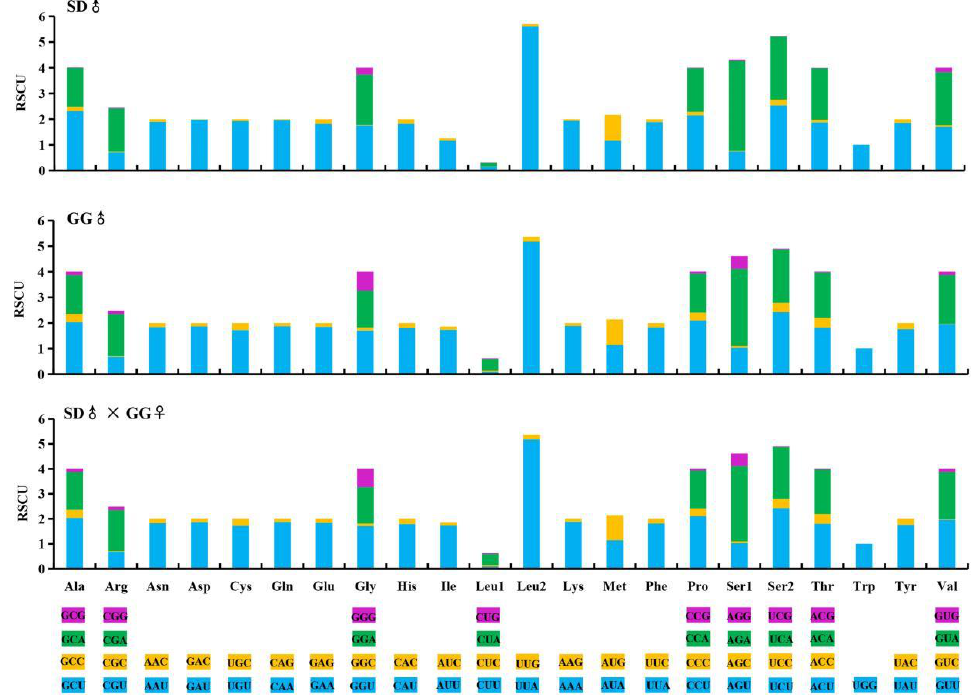
Figure 3. Codon usage numbers (N) and the relative synonymous codon usage (RSCU) among three Thitarodes mitochon- drial genomes.